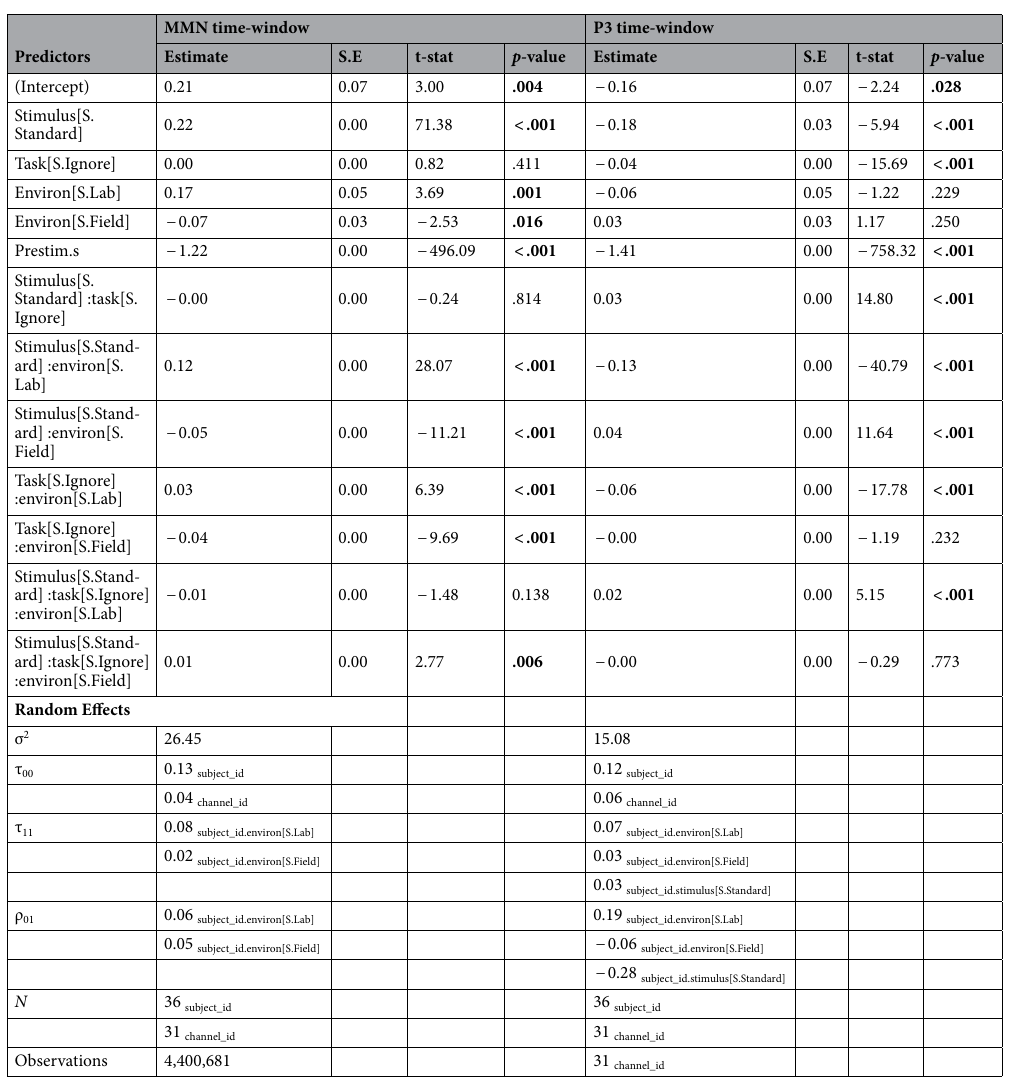
Table 2. Summary of linear mixed-effects models for the MMN and P3 time-windows. Note Factor variables sum-to-zero contrast-coded. Estimate = beta coefficient, S.E. = standard error, stimulus = oddball task stimulus (Deviant, Standard), task = cognitive task condition (Count, Ignore), environ = environmental context (Lab, Field, Campus), prestim.s = prestimulus EEG voltage (scaled), σ 2 = residual variance, τ 00 = random intercept variance, τ 11 = random slope variance, ρ 01 = random effect correlation coefficient, N = number of levels per grouping variable. Bold p-values indicate significance at an alpha threshold =